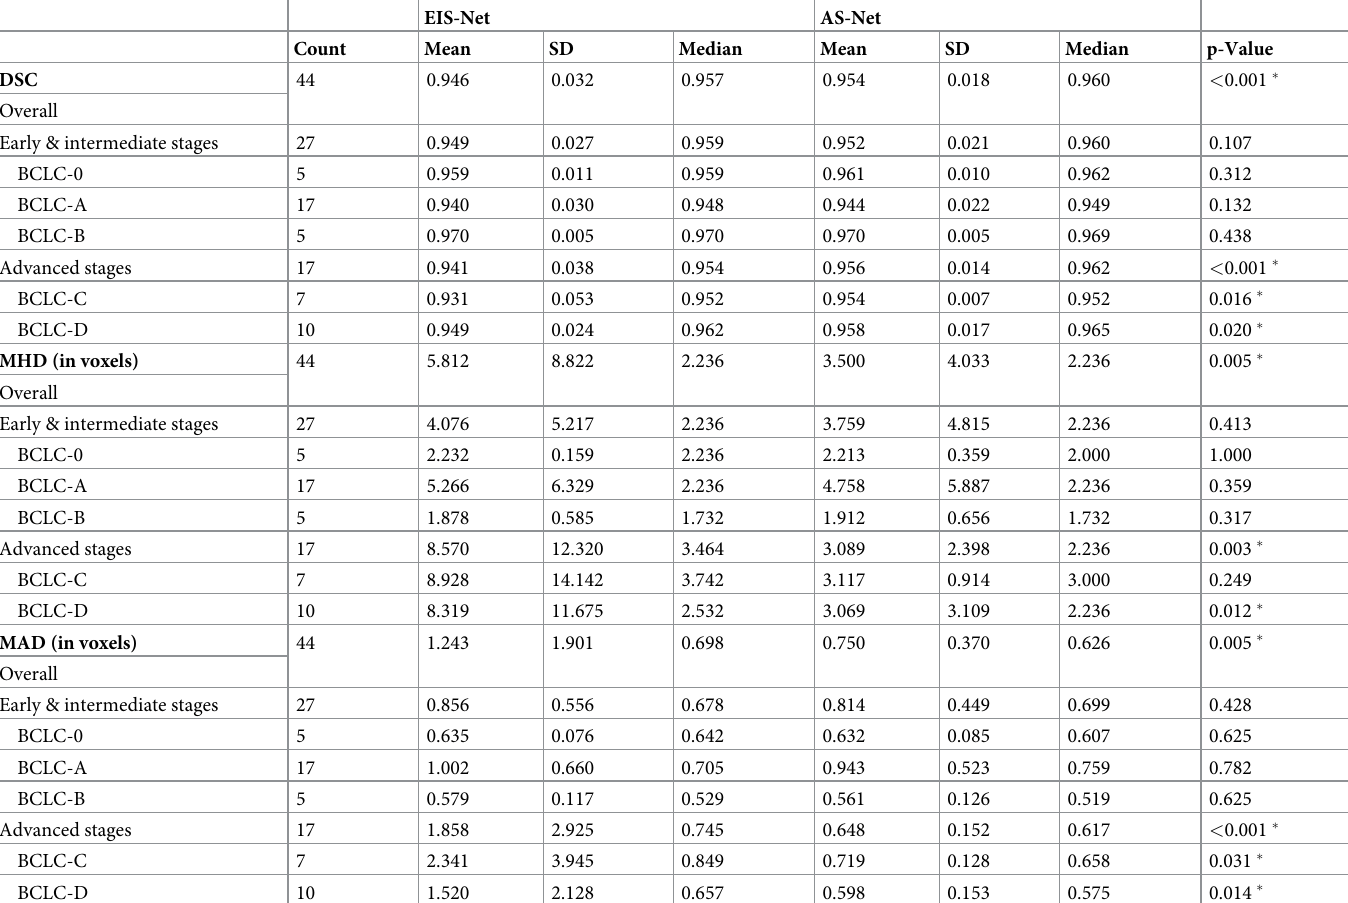
Table 2. Liver segmentation performance (Dice Similarity Coefficient (DSC), Modified Hausdorff Distance (MHD), and Mean Absolute Distance (MAD)) of the EIS-Net and AS-Net methods compared to manual ground-truth across different Barcelona Clinic Liver Cancer (BCLC) cancer